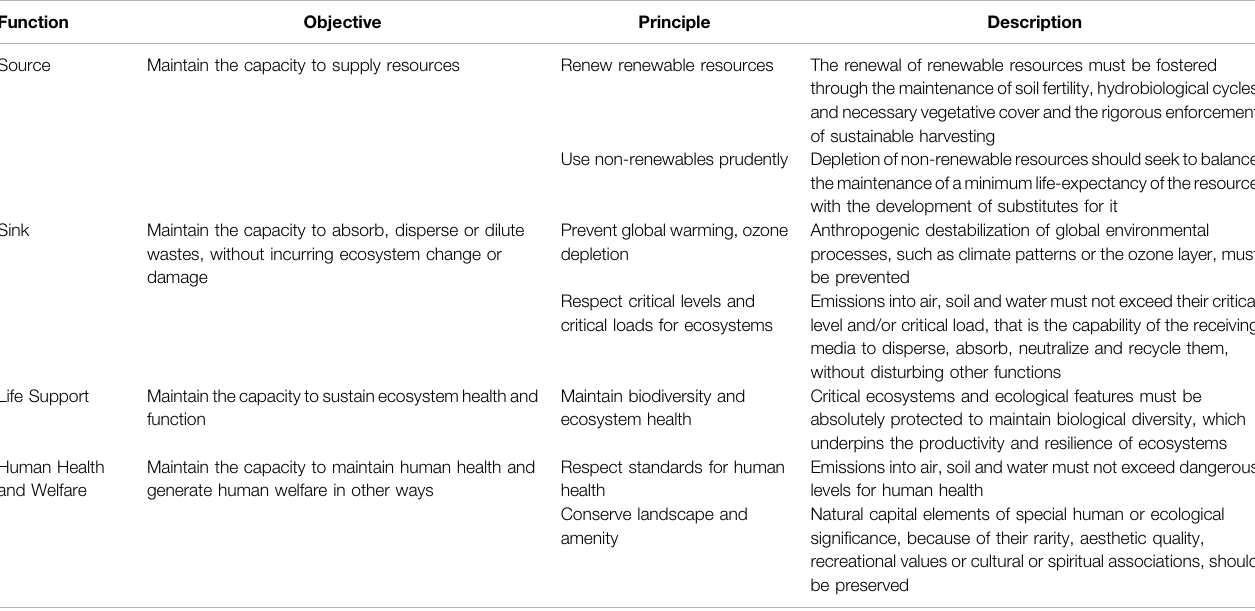
TABLE 3 | Functions of natural capital and environmental sustainability